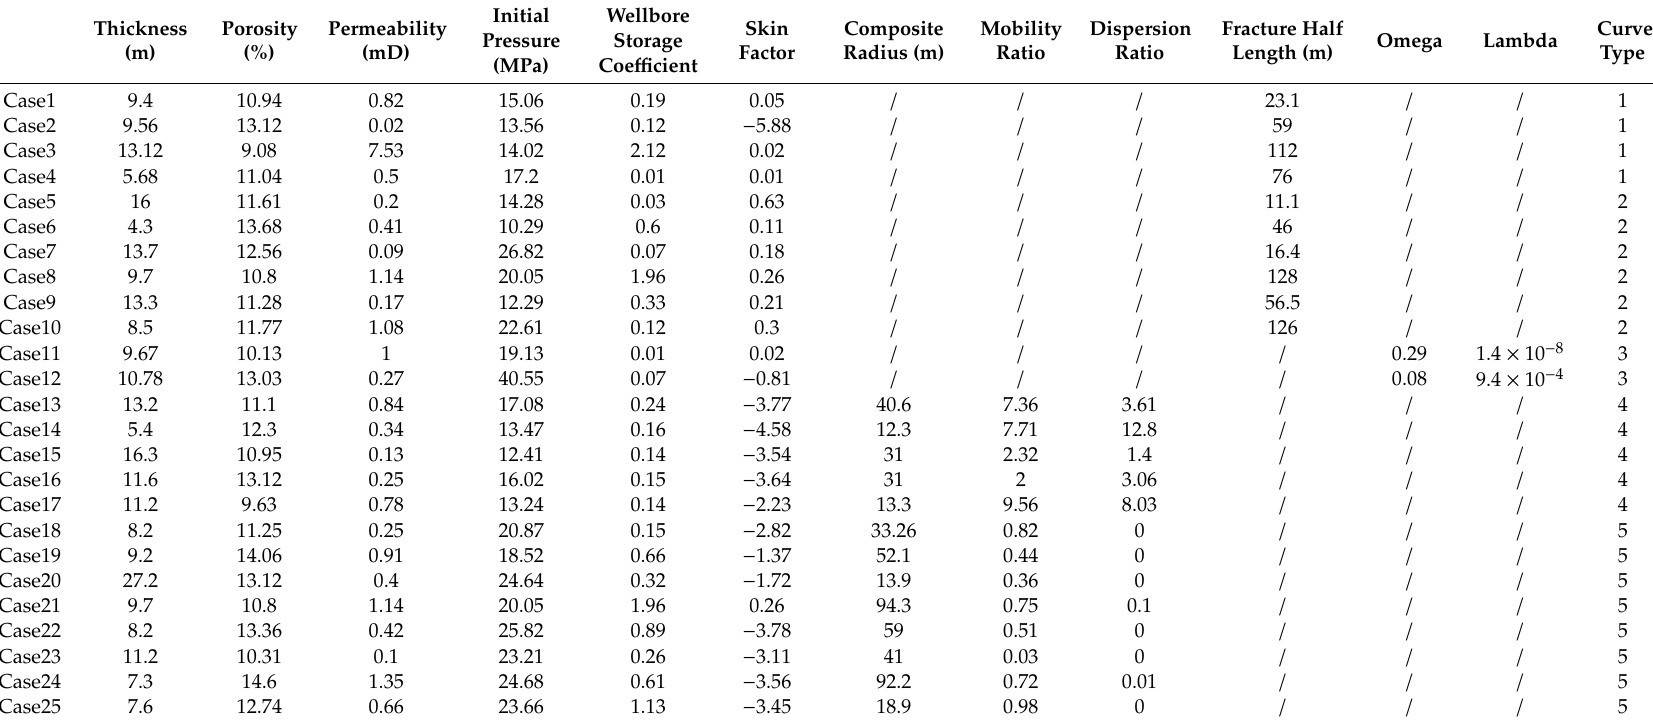
Table A1. Parameter distribution of field cases used in this